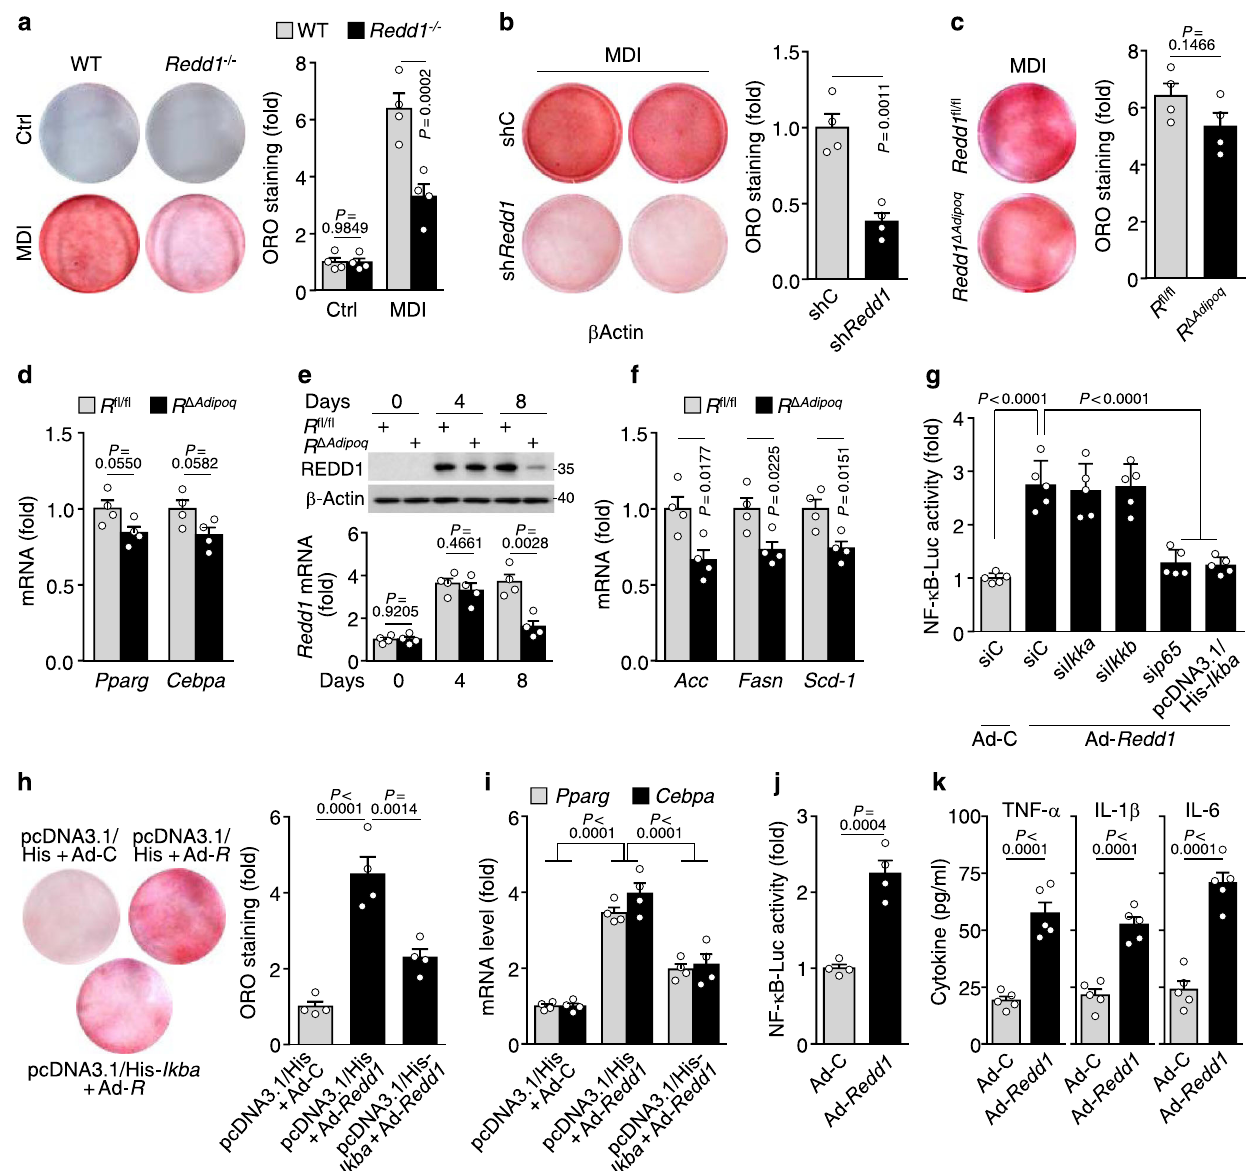
Fig. 5 | REDD1 elicits adipocyte differentiation and macrophage in fl ammation through NF- κ B activation. a – c Representative oil red-O (ORO)-stained images of WTand Redd1 − / − SVFcells( a ),shControl(shC)-orsh-Redd1-transfected3T3-L1cells ( b ), and WT ( Redd1 fl /f l , R fl / fl ) and Redd1 Δ Adipoq ( R Δ Adipoq ) SVF cells ( c ) when cultured in differentiation medium (MDI) and quanti fi cation of relative ORO intensity ( n